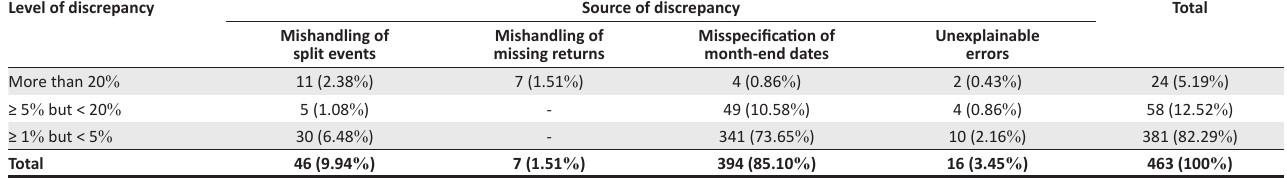
TABLE 2: The distribution of discrepancies greater than 1 % between DataGuide and KisValue by the source and level of the discrepancy. Level of